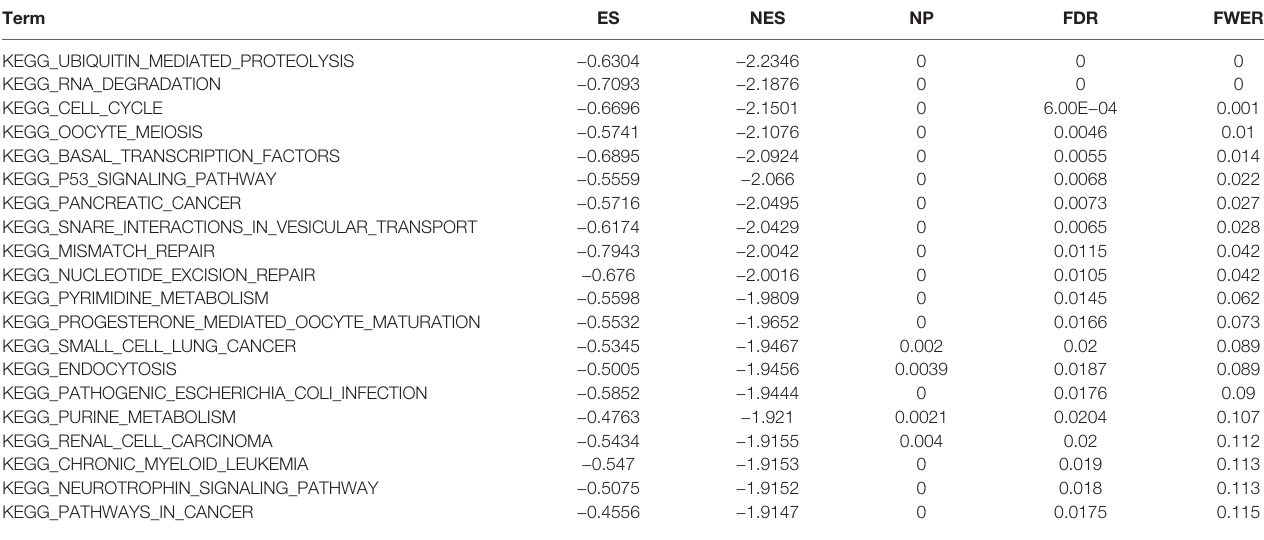
TABLE 1 | The information of KEGG terms from top 20 GSEA enrichment